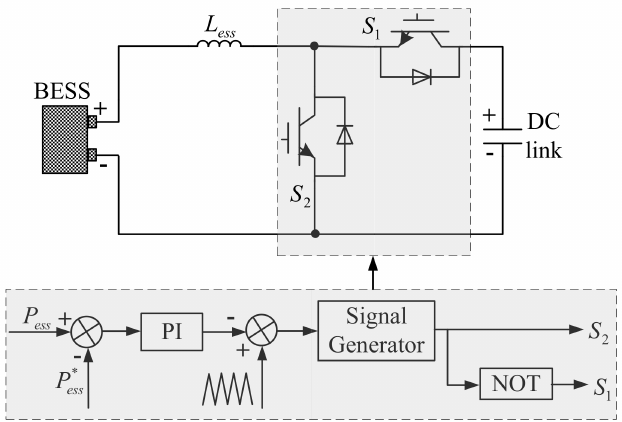
Figure 8. Structure and control of the energy storage system based on DC/DC